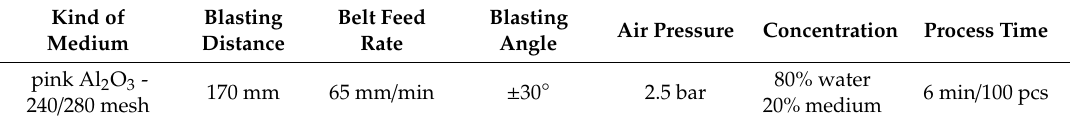
Table 1. Parameters of abrasive jet machining.